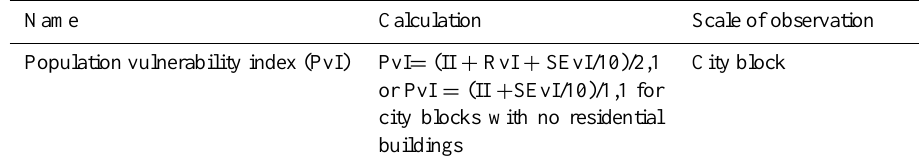
Table 7. Evaluating the overall vulnerability. This table provides the calculation of the population vulnerability index (PVI), which combines residential vulnerability, socio-economic vulnerability and the isolation index. The overall measure is provided at the city-block scale, although the socio-economic vulnerability is computed at the district scale. Figure 12 shows a map representing PVI.